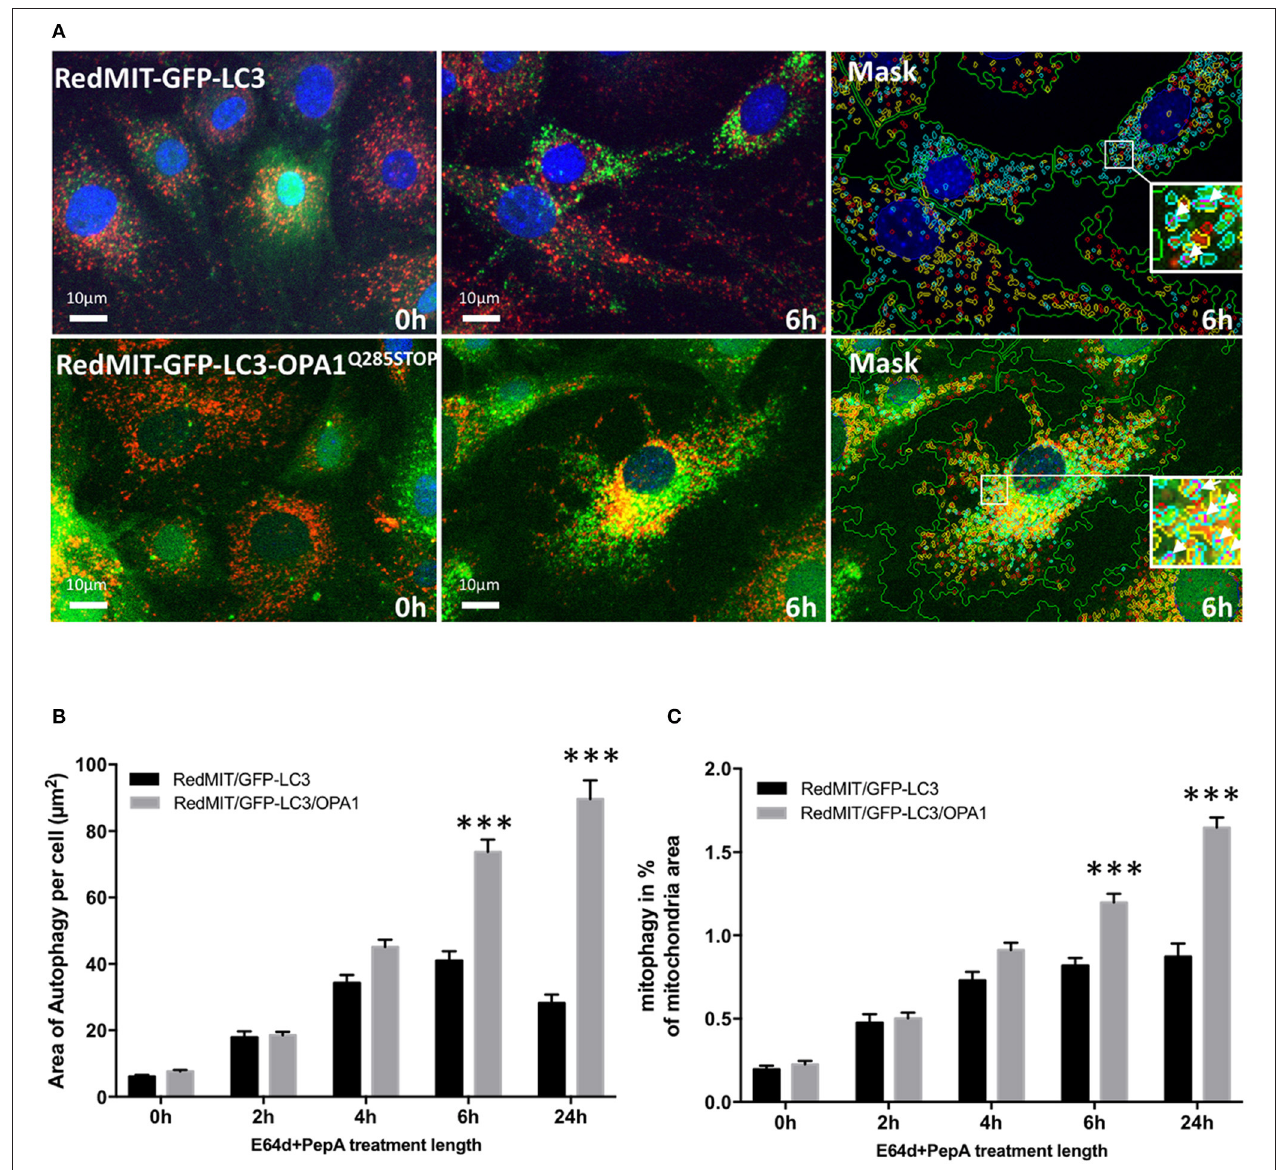
FIGURE 4 | The OPA1 Q285STOP mutation induces mitophagy in MEFs. (A) Representative images of the IN Cell 1000 high content imaging acquisition system. The cells from both RedMIT-GFP-LC3 and RedMIT-GFP-LC3-OPA1 Q285STOP were grown in glucose media (0h) supplemented with E64d/Pepstatin A for 6h before fixation. The images are analyzed using a homemade protocol developed using the IN Cell developer toolbox (Diot et al., 2015) resulting in a “mask” picture (cyan: autophagosomes; red: “short” mitochondria; yellow: “long” mitochondria; purple: “colocalization” between autophagosome and mitochondria signals). The white arrows in the insets indicate the colocalization events between mitochondrial and autophagosome signal. (B) Lysosomal inhibitors E64d/Pepstatin A were added to cells growing in glucose media to block the processing of autophagolysosomes. As shown on the graph a greater accumulation of autophagosomes is observed in MEFs from the RedMITGFP-LC3-OPA1 Q285TOP mouse compared to the RedMIT-GFP-LC3-OPA1 + / + mouse, indicating a greater flux of autophagy when the OPA1 mutation is present. (at least 500 cells counted, regression p < 0.05). (C) In similar conditions, a greater flux of mitophagy (mitochondrial fragments colocalizing